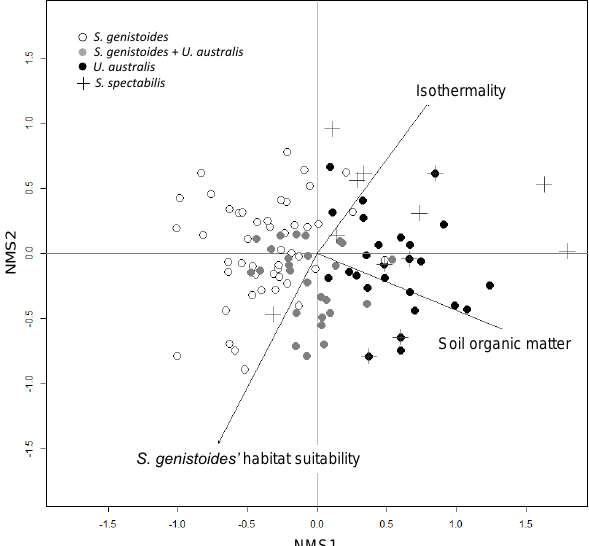
Figure 2. Non-metric multidimensional scaling ordination of study sites based on shrub cover. Dots and crosses represent study sites with the presence of the three main indicator